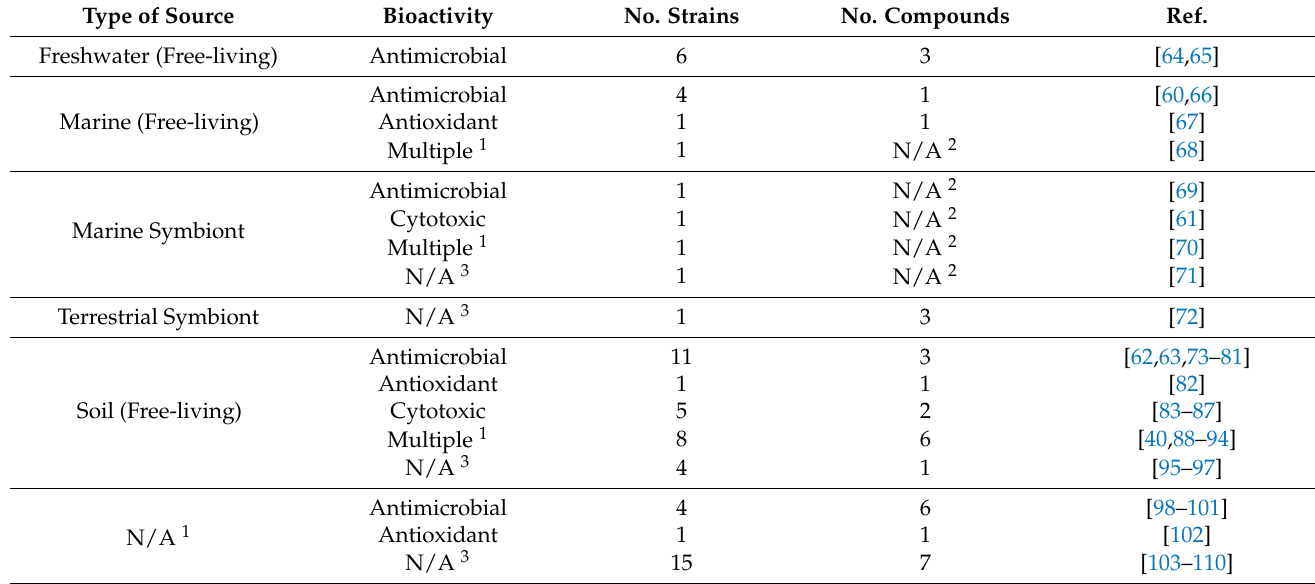
Table 1. Number of strains and compounds by bioactivity and type of source.